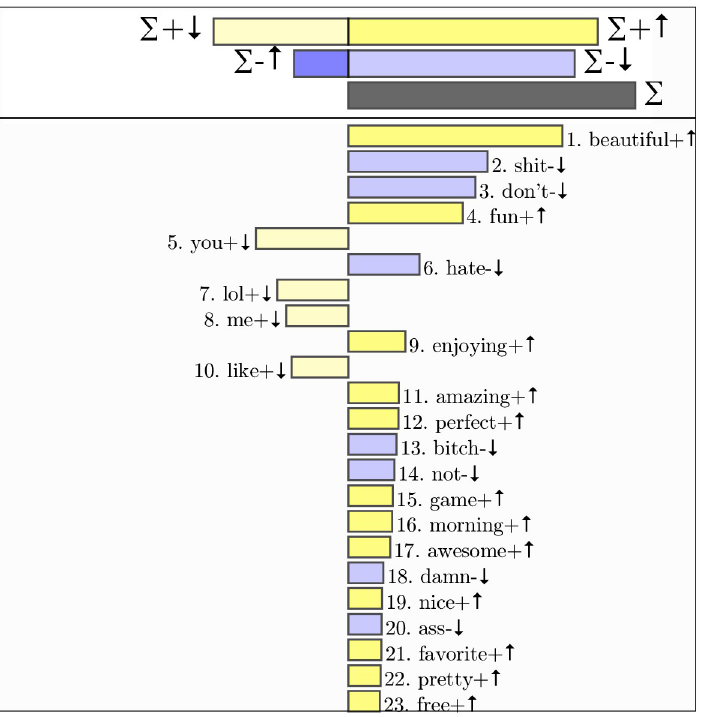
Fig 2. Wordshift diagram between park and control tweets. Differences in word frequency between park and control tweets across all cities, in order of decreasing contribution to the difference in average happiness. The right side represents the park tweets, with an average happiness of 5.96. The left side represents the control tweets, with an average happiness of 5.86. Purple bars represent words � 4 (with − symbol) on the Hedonometer scale. Yellow bars represent words � 6 (with + symbol) on the Hedonometer scale. Arrows indicate whether a word was more or less frequent within that set of tweets compared to the other text. For example, beautiful is a positive word (yellow) with higher frequency in in-park tweets that contributes to its higher average happiness than the control tweets. Don’t is a negative word (purple) that appears less frequently in in-park tweets, also resulting in a higher average happiness score compared to control groups. Going against the overall trend, the positive words lol and me are used less often in parks. This wordshift uses tweets from 1,000 random in-park tweets and 1,000 control tweets from each city.